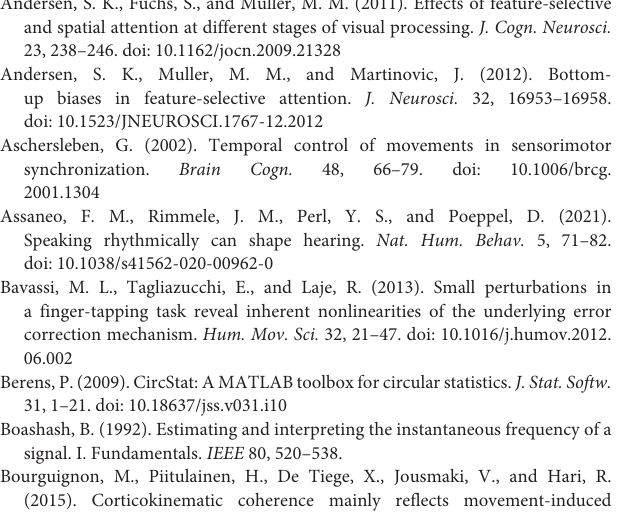
SUPPLEMENTARY FIGURE 3 | Component #2 (correlations with behavioral outcome measures). The stability index was computed from the second component, and its correlations with the behavioral outcome measures were tested. Correlations were considerably weaker than the ones for the component associated with the highest eigenvalue, as quantified by the Spearman correlation coefficients. Results are showed in the original scale and transformed to ranks. This evidence suggests that the first component alone is related to neural entrainment in the context of the experimental task. Acknowledging that we still cannot completely rule out the merging of different neural processes across components, the approach hereby proposed has proved to be valid in extracting one single component related to auditory-motor